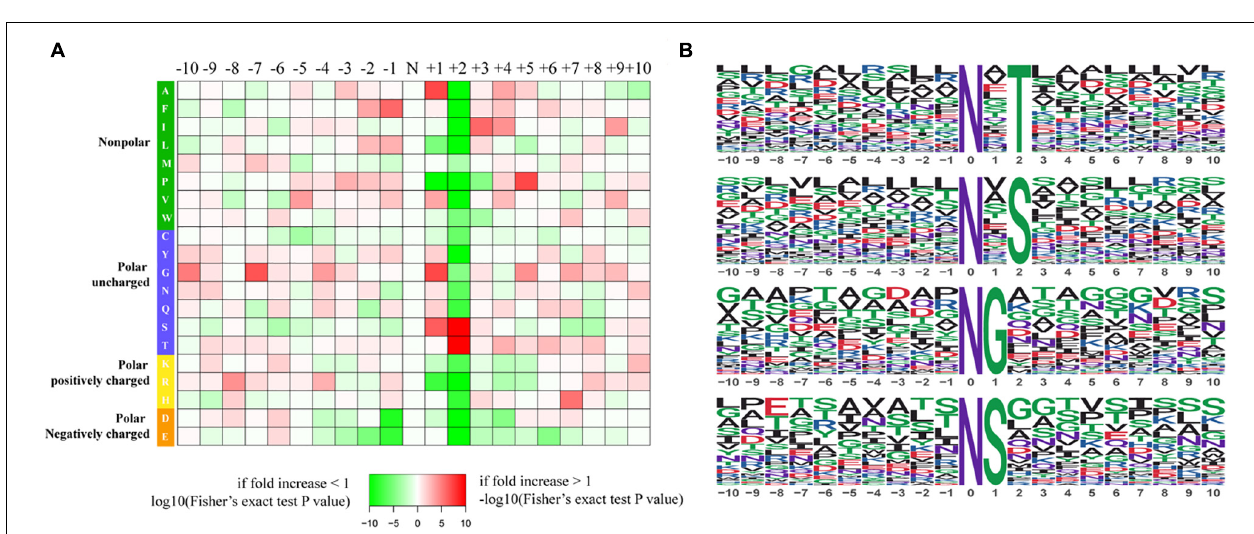
FIGURE 1 | Overview of the global identification of N-glycoproteins in Phaeodactylum tricornutum. (A) General workflow of the N-glycoprotein analysis. (B) Mass error distribution of the identified N-glycopeptides. (C) Length distribution of the N-glycopeptides. (D) The number of N-glycosylation modification sites per protein.